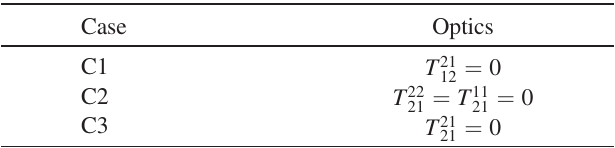
TABLE IV. The three subcases for case C with special optics.